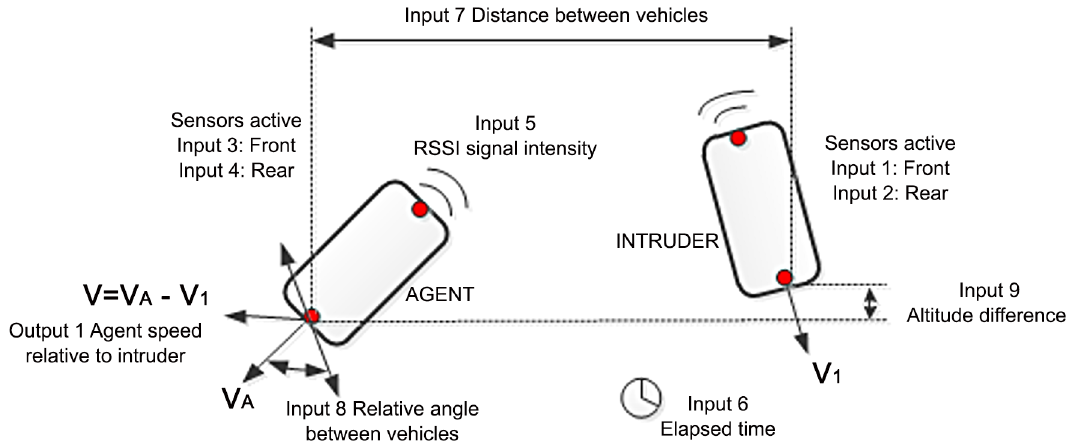
Fig 2. Selected input and output parameters for analysis.